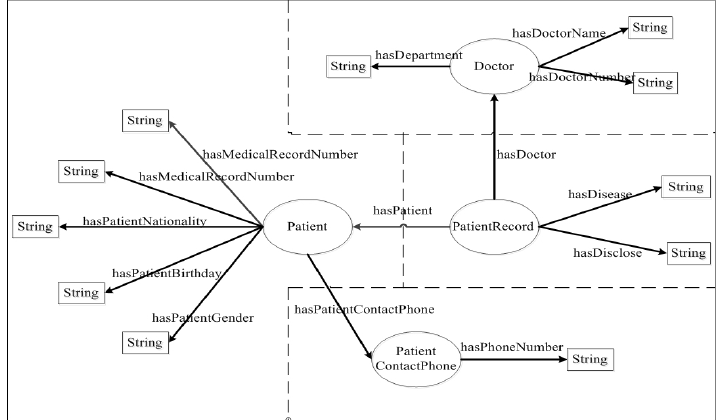
Figure 8. A modularized and fragmented putative ontology for personal medical